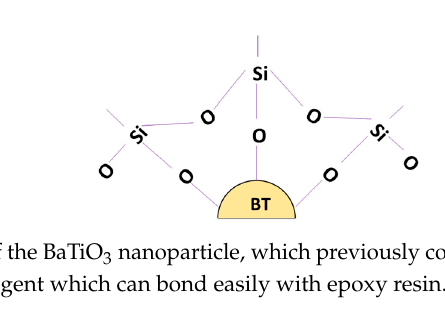
Figure 27. The surface of the BaTiO 3 nanoparticle, which previously contained hydroxyl groups now is replaced by a coupling agent which can bond easily with epoxy resin.